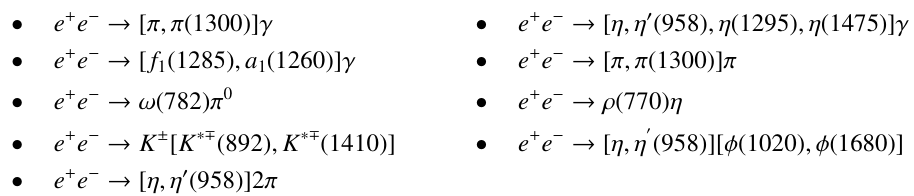
Figure 2. The cross section of e + e − zoomed